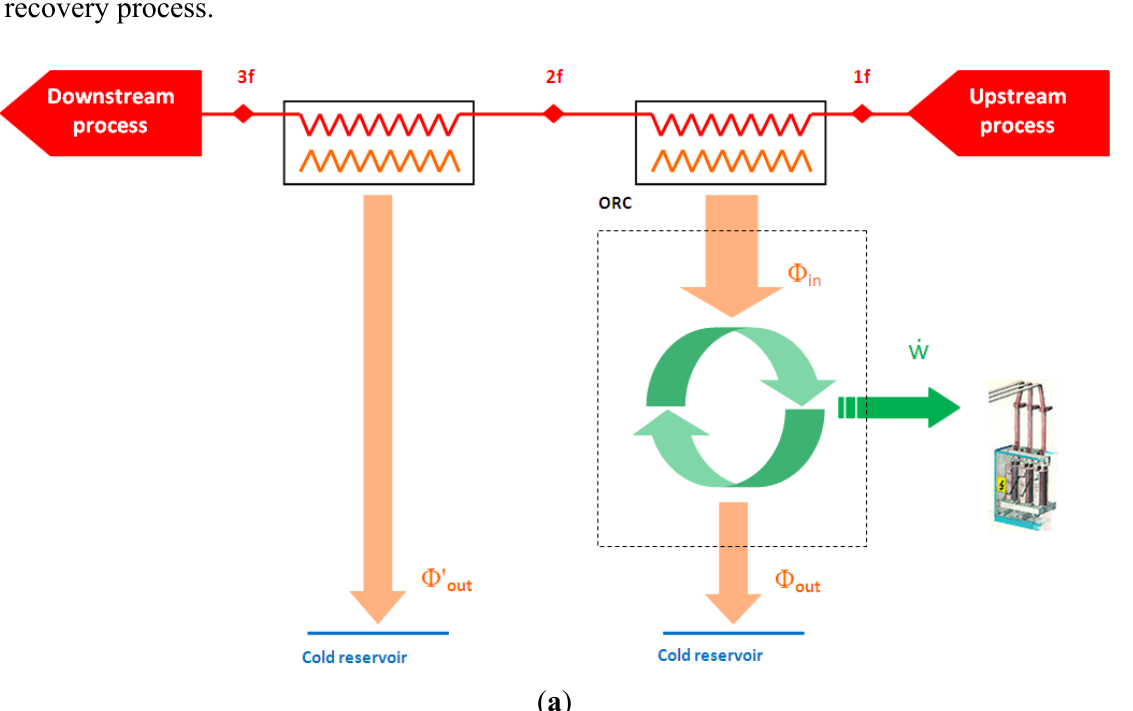
Figure 1. ( a ) Scheme of one cycle recovery process; ( b ) Scheme of two-cycle cascade recovery